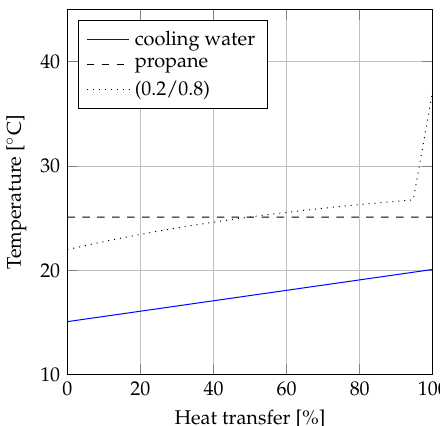
Figure 8. ˙ QT -diagram of condensation when ∆ T m = 7.2 ◦ C for propane and propane/i-butane